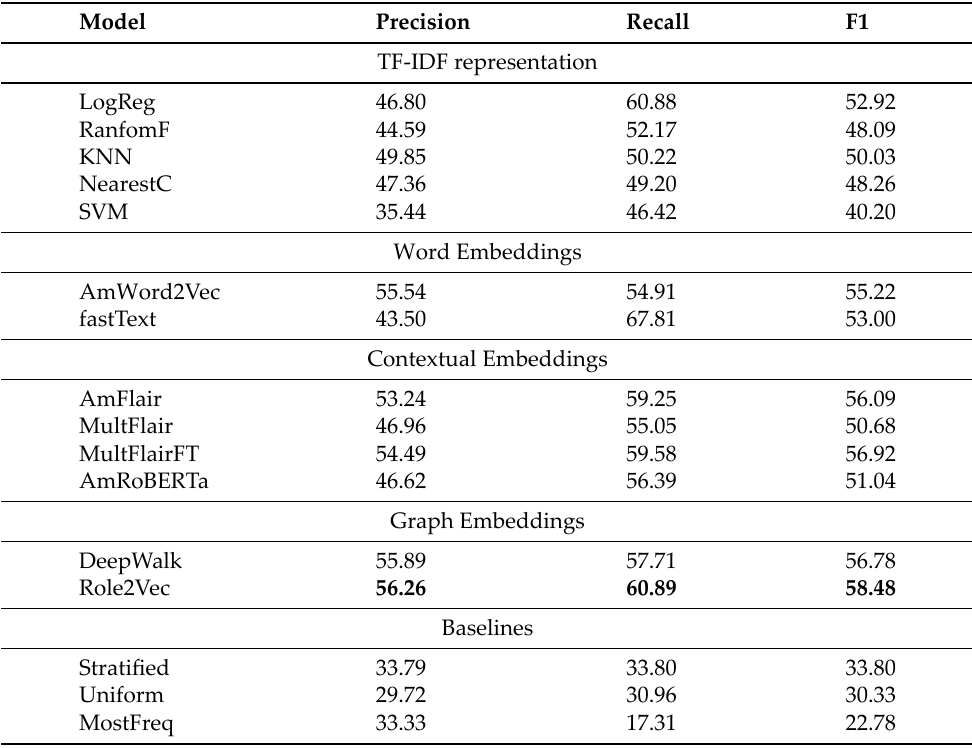
Table 8. Experimental results of the test sets on the sentiment classes: “Positive”, “Negative” and “Neutral”